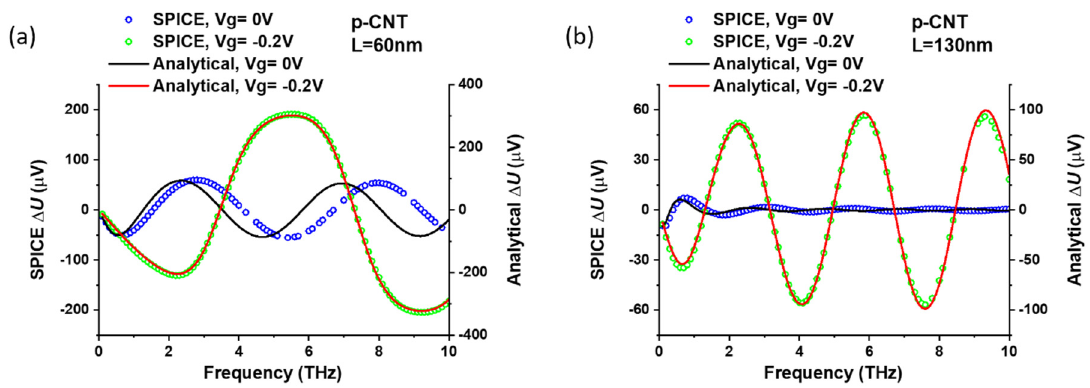
Figure 6. Frequency dependent spectrometer response in the above threshold regime ( V gs = 0, − 0.2 V ) for the p-CNTFET with ( a ) L = 60 nm, and ( b ) L = 130 nm.